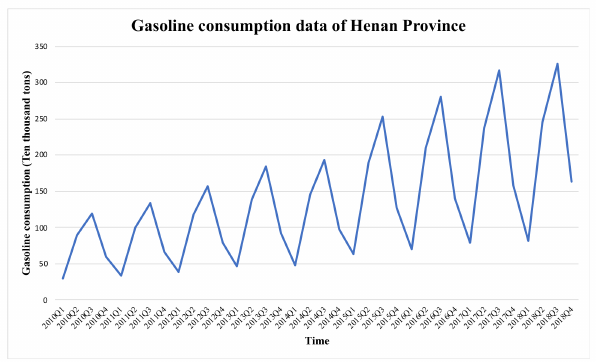
Figure 4. Gasoline consumption data of Jiangsu Province.